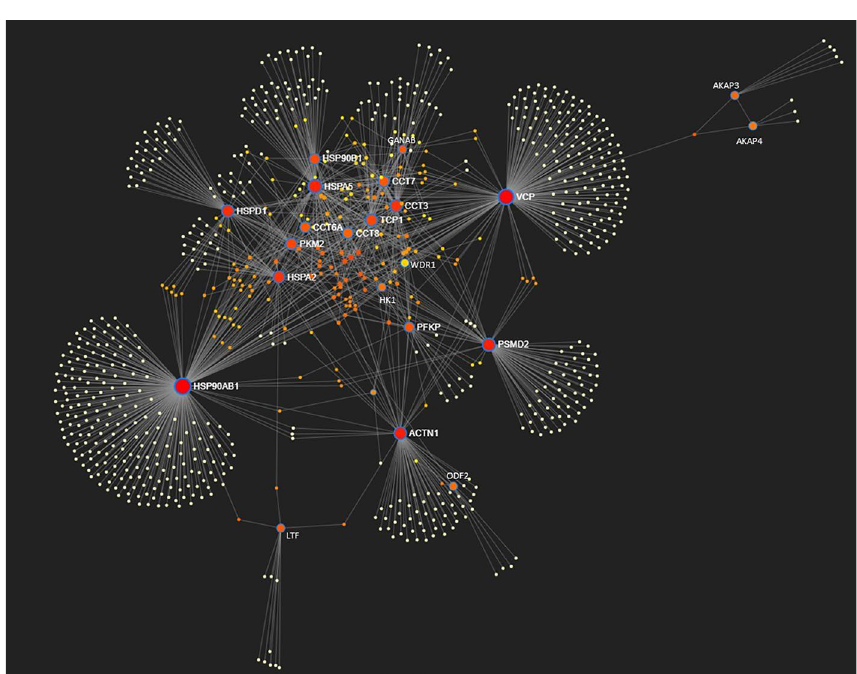
Figure 6. Protein–protein interactions network produced by NetworkAnalyst 3.0. Significant factors (seeds) are highlighted with a blue circle. The size of the nodes is based on their degree (connectivity) values, with a big size for large degree values. The color of the nodes is proportional to their betweenness centrality values, starting from red for higher